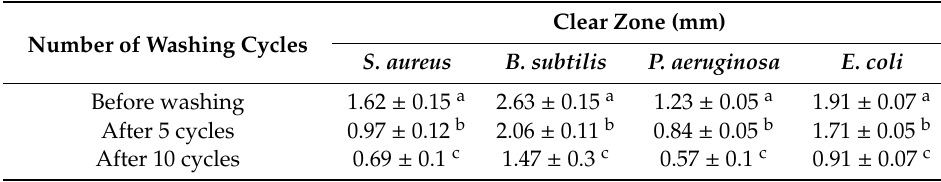
Table 2. The e ff ects of repeated washing on the antibacterial properties of silver nanoparticles finished fabrics with the qualitative assessment